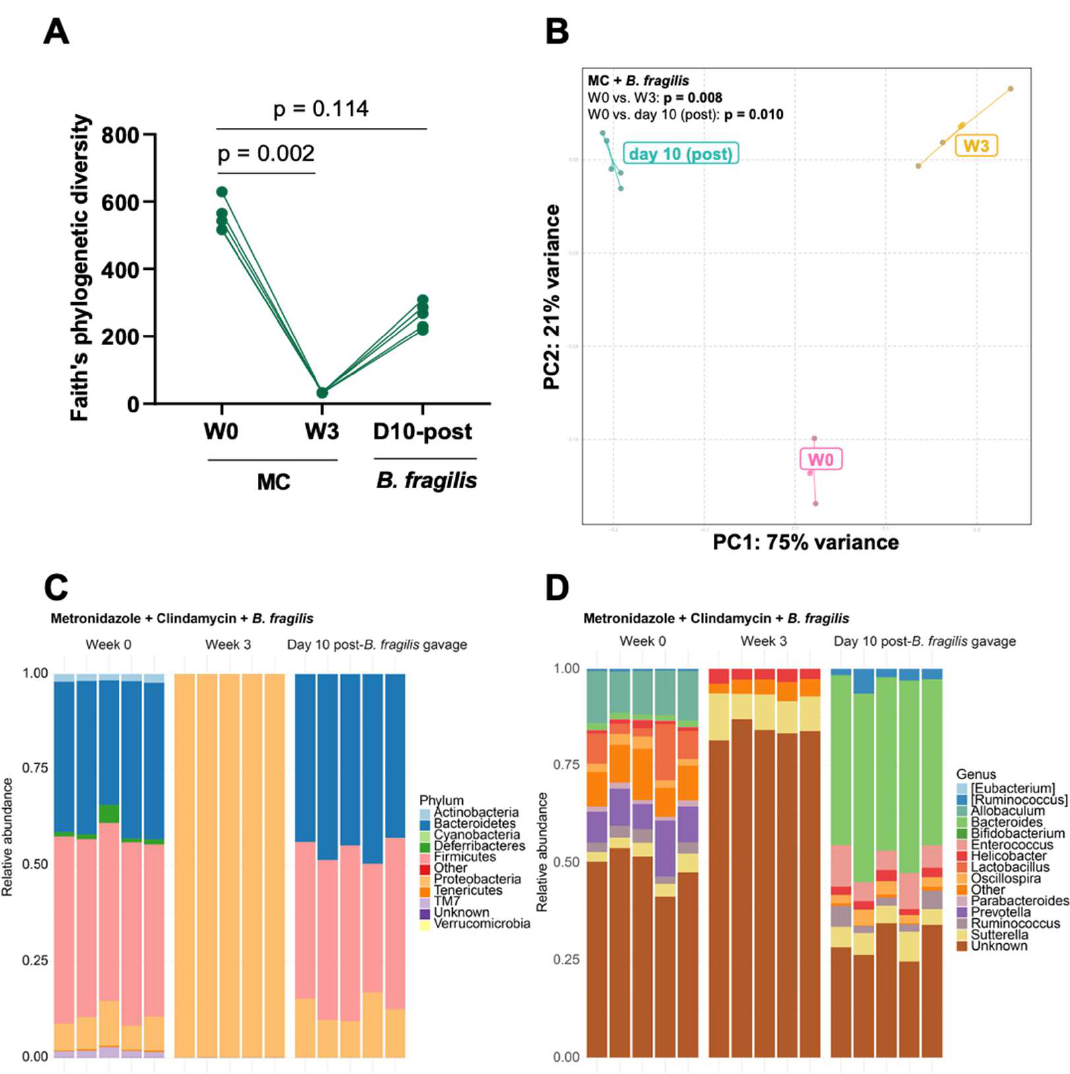
Figure 7. Transplantation of B. fragilis into MC-treated mice. ( A ) α-diversity measured using Faiths’ phylogenetic index. p values for comparison between the baseline and the different time points are shown. ( B ) Principal coordinate analysis plots illustrating differences in β-diversity based on weighted Unifrac. stacked relative abundance plots at the ( C ) genus level and ( D ) phylum level. (n = 5